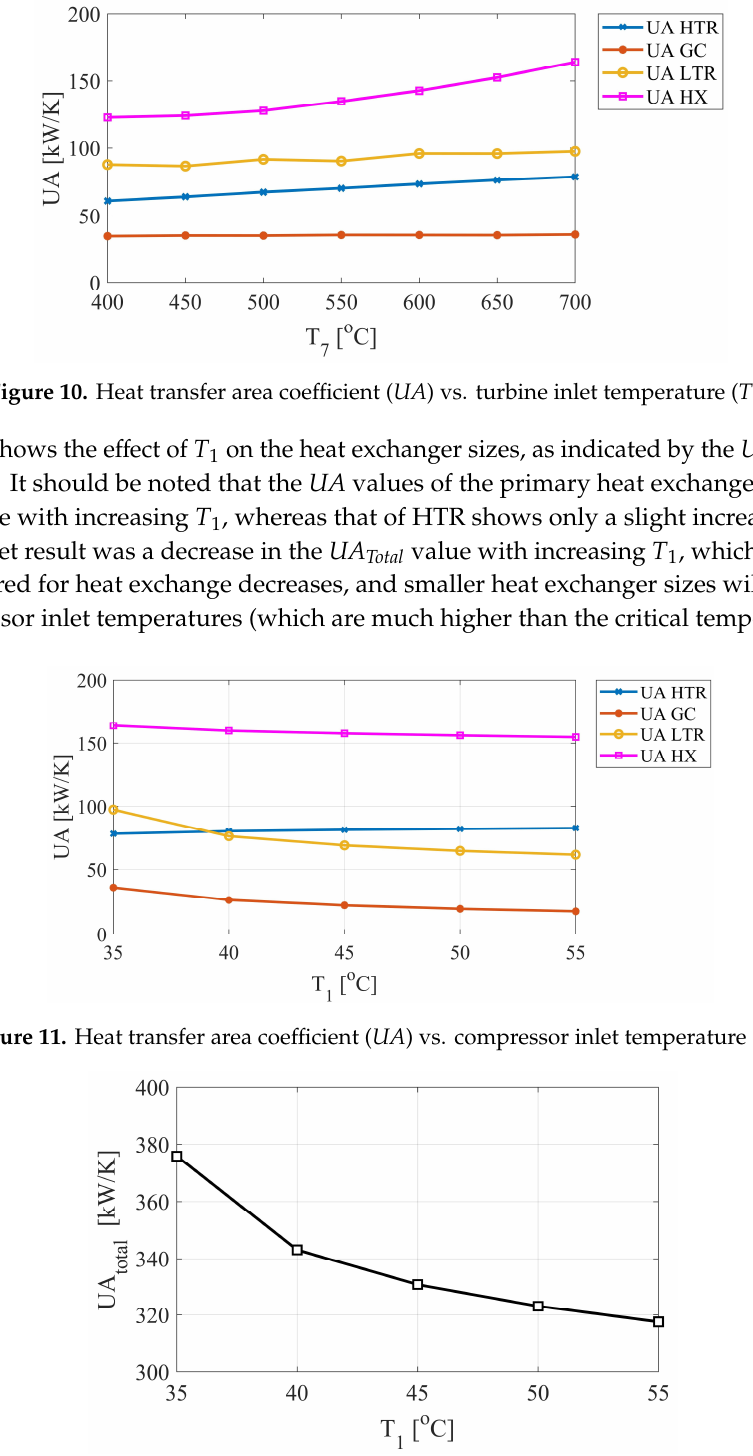
Figure 12. Total heat transfer area coe ffi cient ( UA Total ) vs. compressor inlet temperature ( T 1